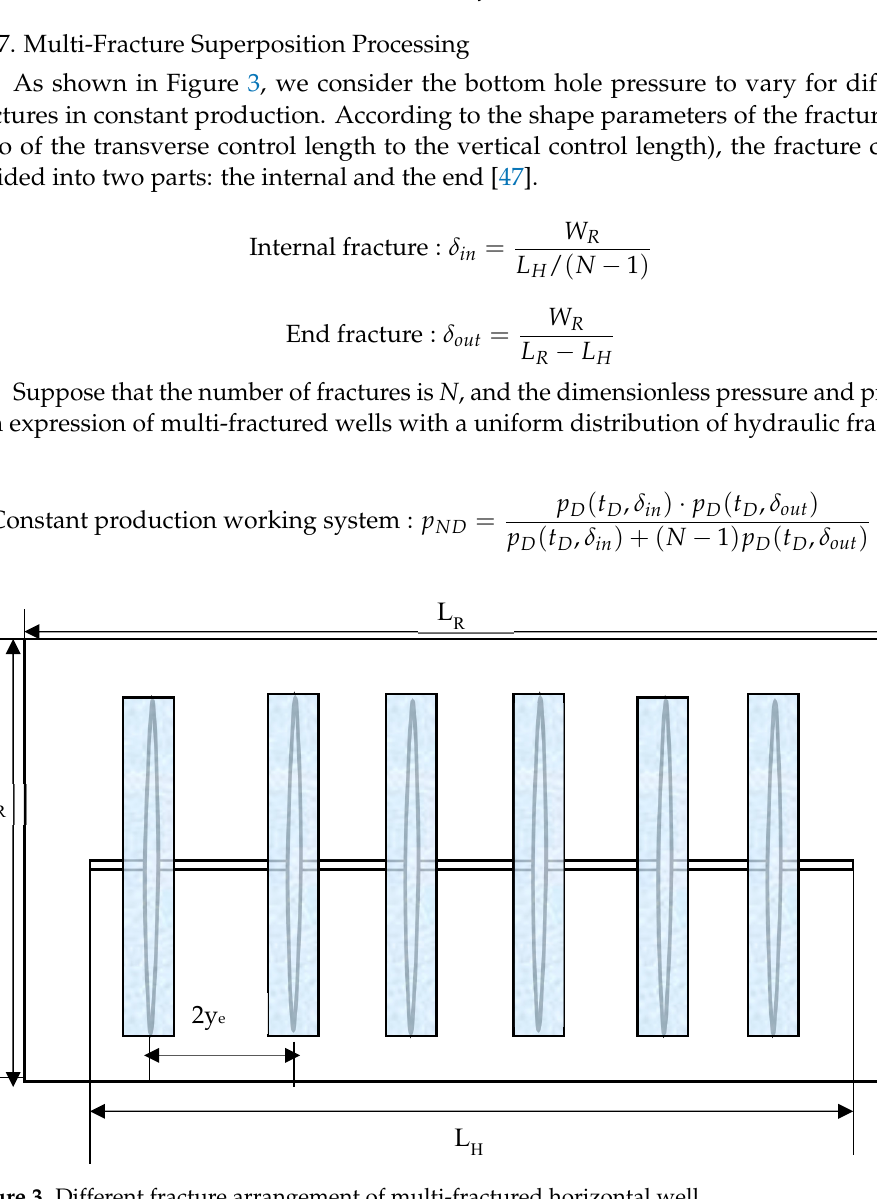
Figure 3. Different fracture arrangement of multi-fractured horizontal well.